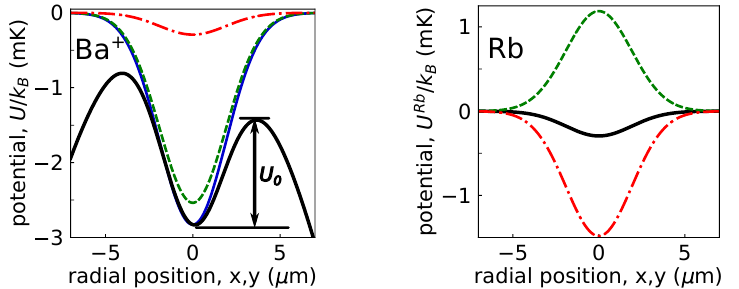
Figure 2. ( left ) Calculated optical potential for Ba + at z = 0 (blue, solid) with VIS (green, dashed) and NIR (red, dash-dotted) contributions. Taking into account electrostatic defocusing and stray fields (black, thick) yields an effective trap depth of U 0 / k B ≈ 1.4 mK. ( right ) Calculated bichromatic potential for Rb (solid, black) with a trap depth U Rb / k B ≈ 300 µ K. From Schmidt, Weckesser, 0 Thielemann, Schaetz, and Karpa (2020)